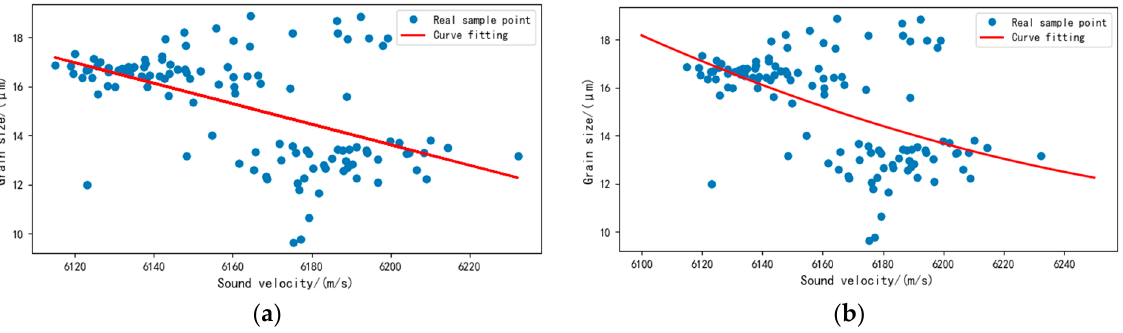
Figure 9. Two single ultrasound evaluation models: ( a ) first-order sound velocity model, ( b ) second-order sound velocity model.